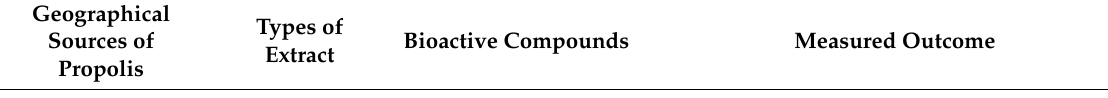
Table 7. Anti-inflammatory properties of propolis in wound